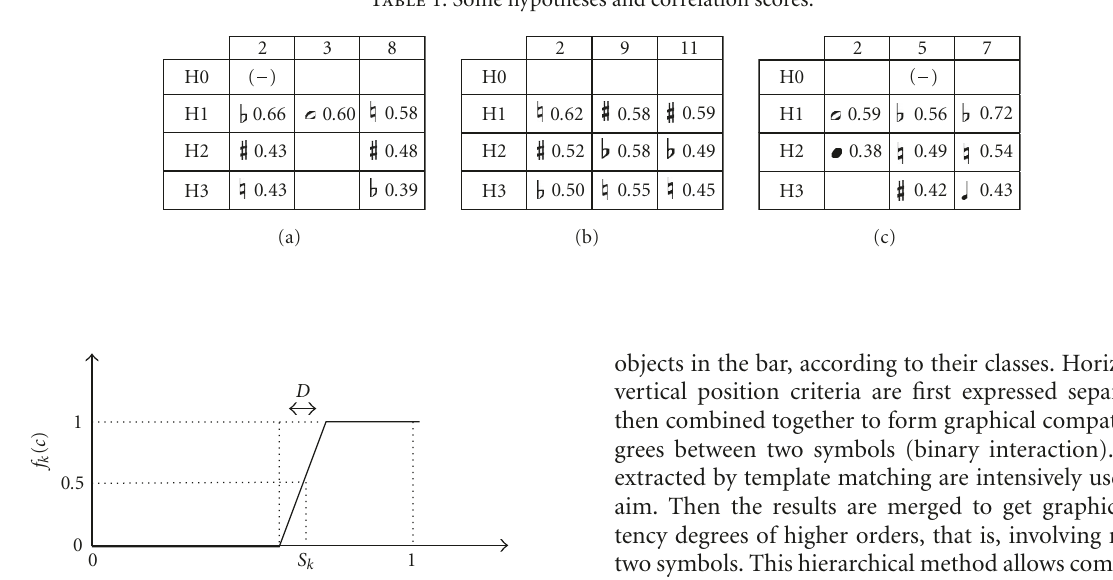
Table 1: Some hypotheses and correlation scores.